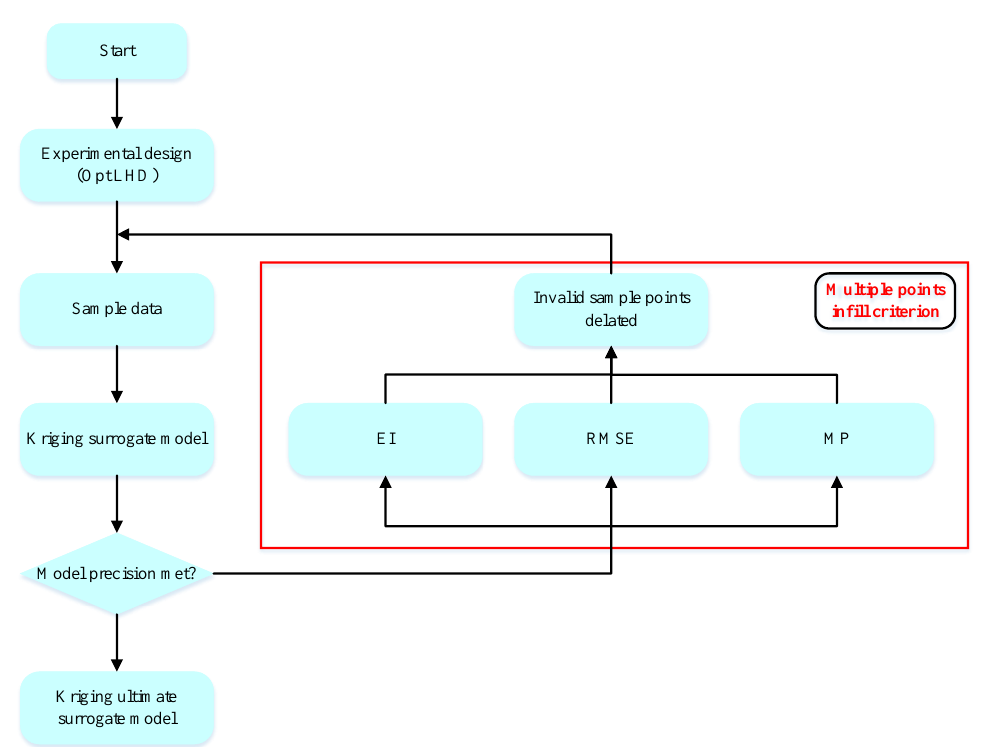
Figure 1. The flowchart of EI&MP&RMSE method.